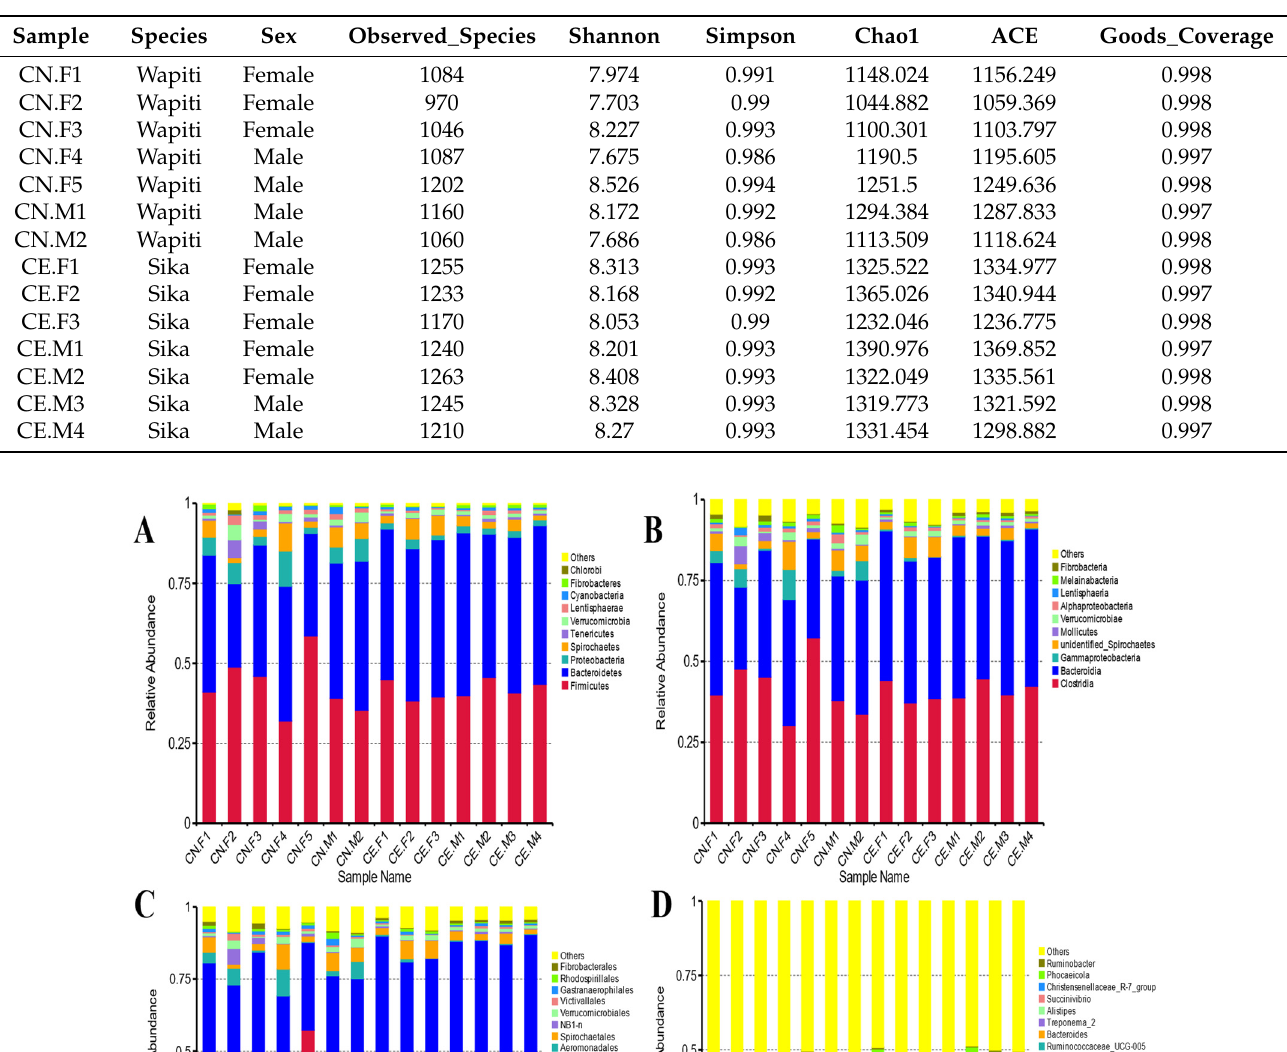
Table 2. Alpha diversity of the gut microbiota in fecal samples.